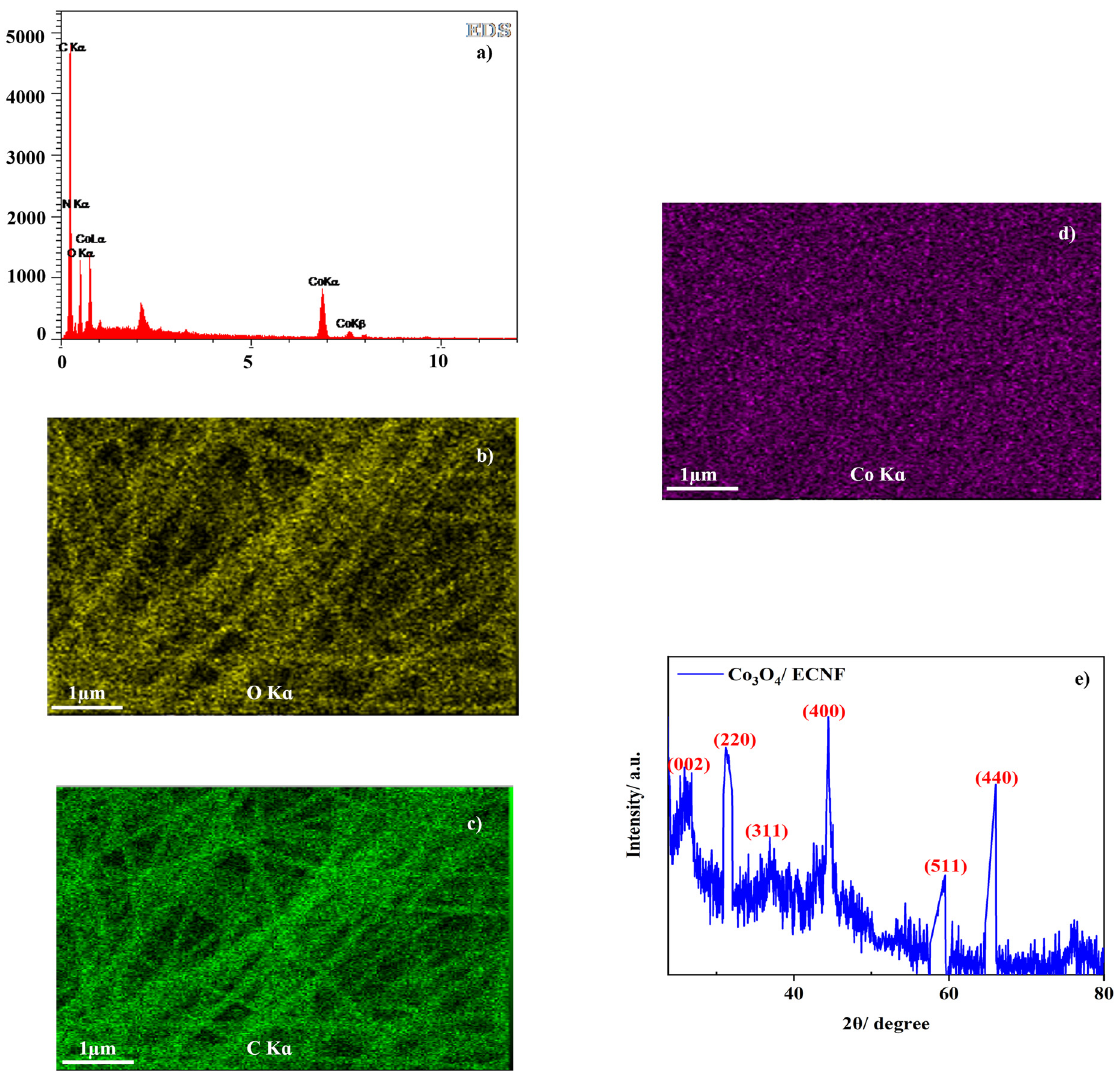
Figure 2: ( a ) EDS diagram; element mapping of ( b ) O, ( c ) C, and ( d ) Co; and ( e ) XRD of Co 3 O 4 /ECNF nanocomposite.